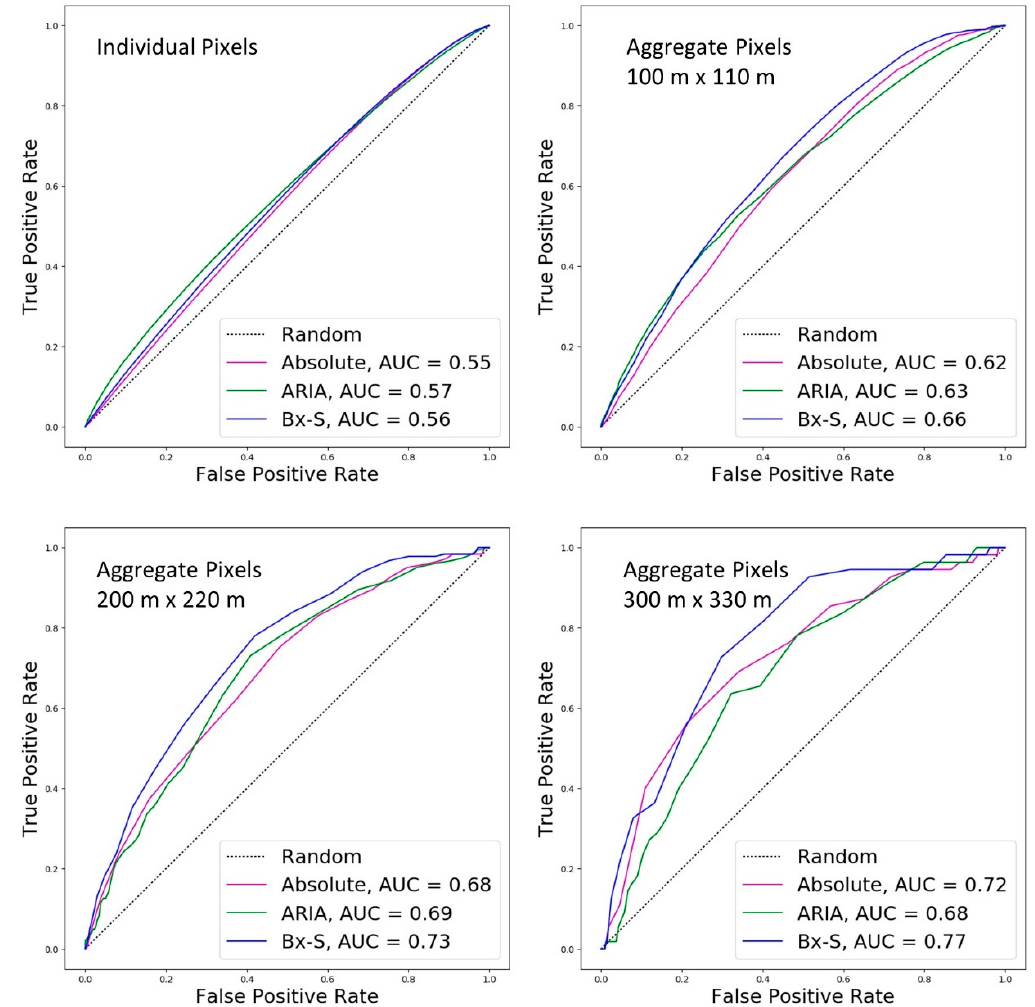
Figure 9. ROC curves for three different SAR coherence-based classifiers, plotted at a range of resolutions from individual 20 m × 22 m pixels up to 300 m × 330 m aggregate pixels. The dotted lines show the performance of a random classifier (AUC = 0.5). Masks shown in Figure 7 were applied to the data before calculation. The Bx-S method outperforms the other classifiers for aggregated pixels.